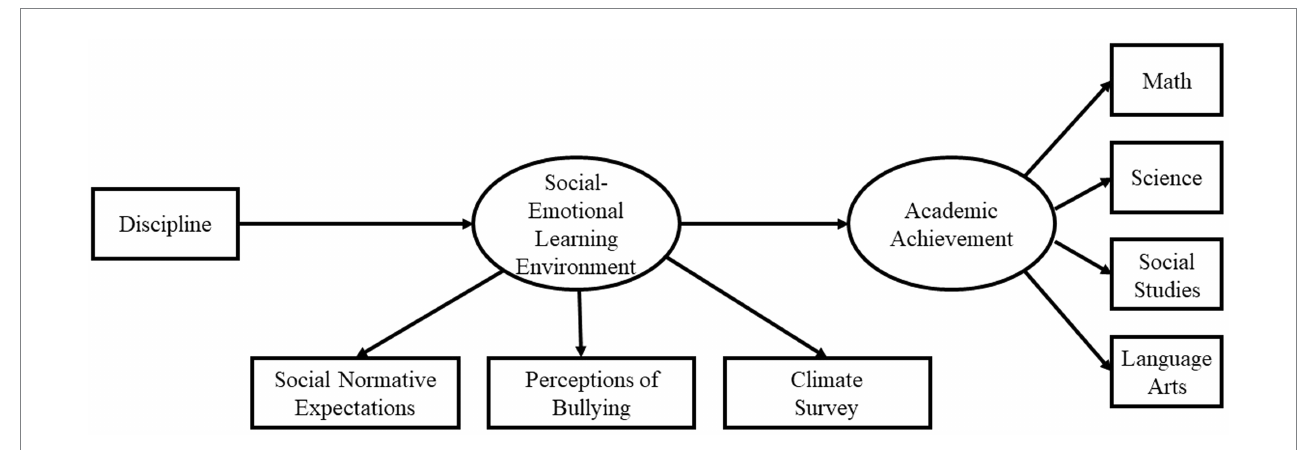
FIGURE 4 Proposed alternative